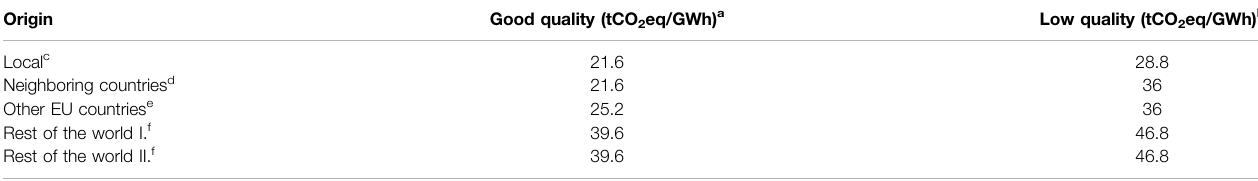
TABLE 2 | Carbon footprint of the different lignocellulosic biomass by category (in tCO 2 eq/GWh).